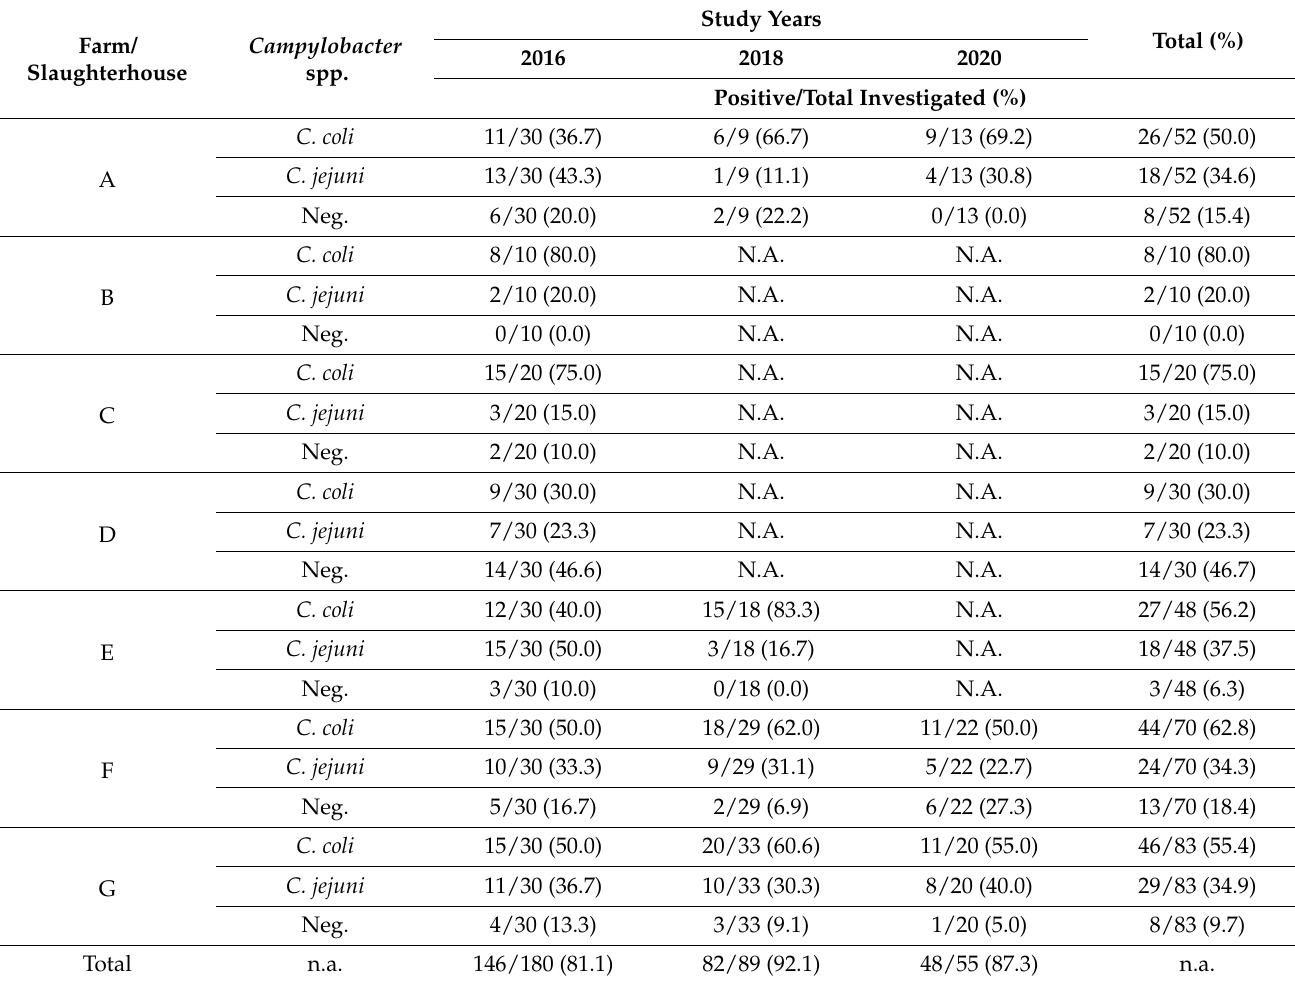
Table 1. Distribution of the identified Campylobacter spp. in the tested broiler chicken cecum samples, according to their origin and study